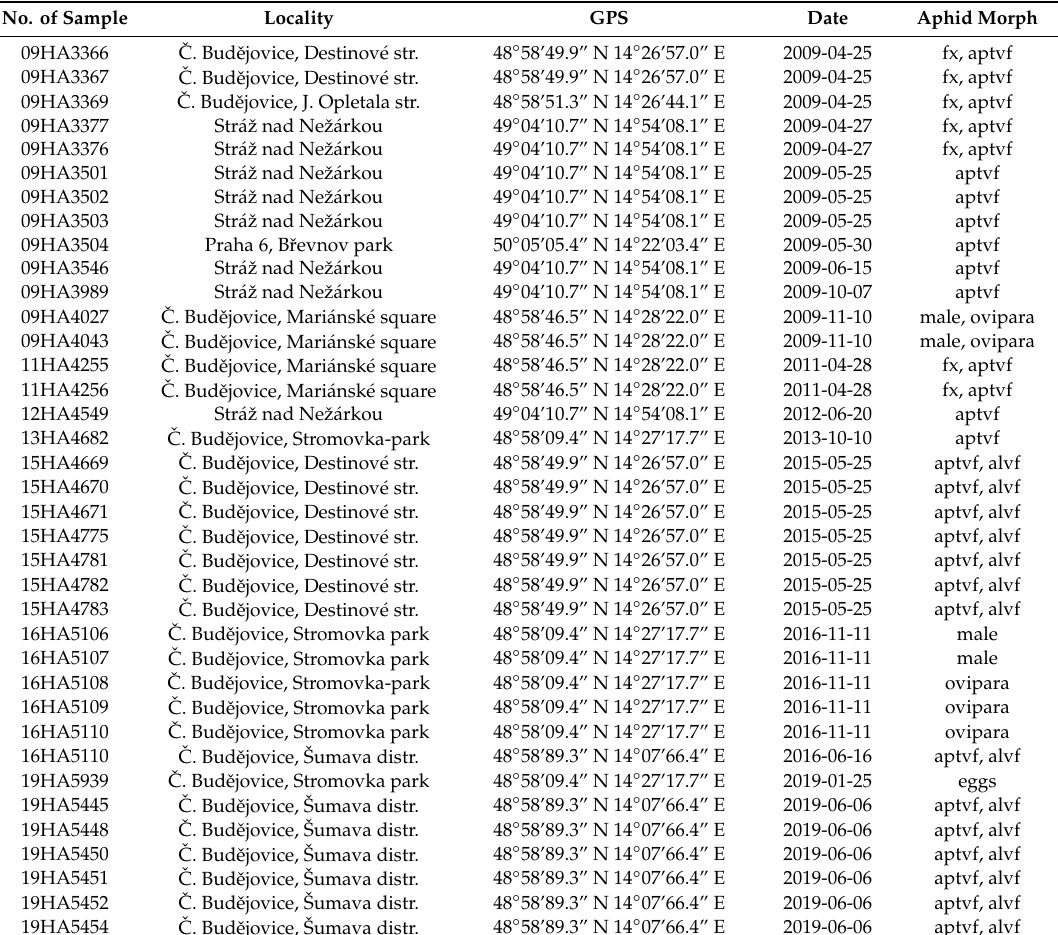
Table 1. Microscopic slides of Cinara splendens (Gillette and Palmer, 1924) collected in South Bohemia from Pseudotsuga menziesii (Mirb.) Franco. Legend: fx = fundatrix; aptvf = apterous viviparous female; alvf = alate viviparous